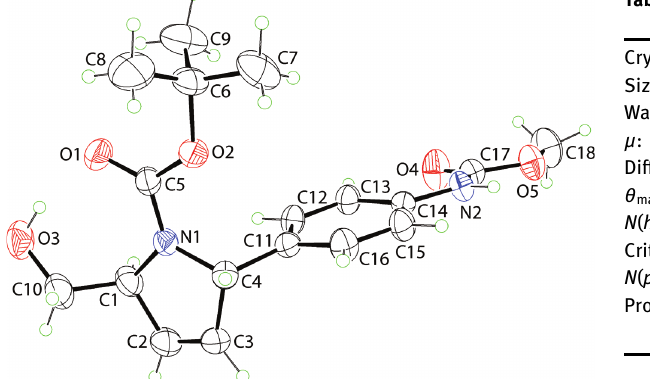
Table 1: Data collection and